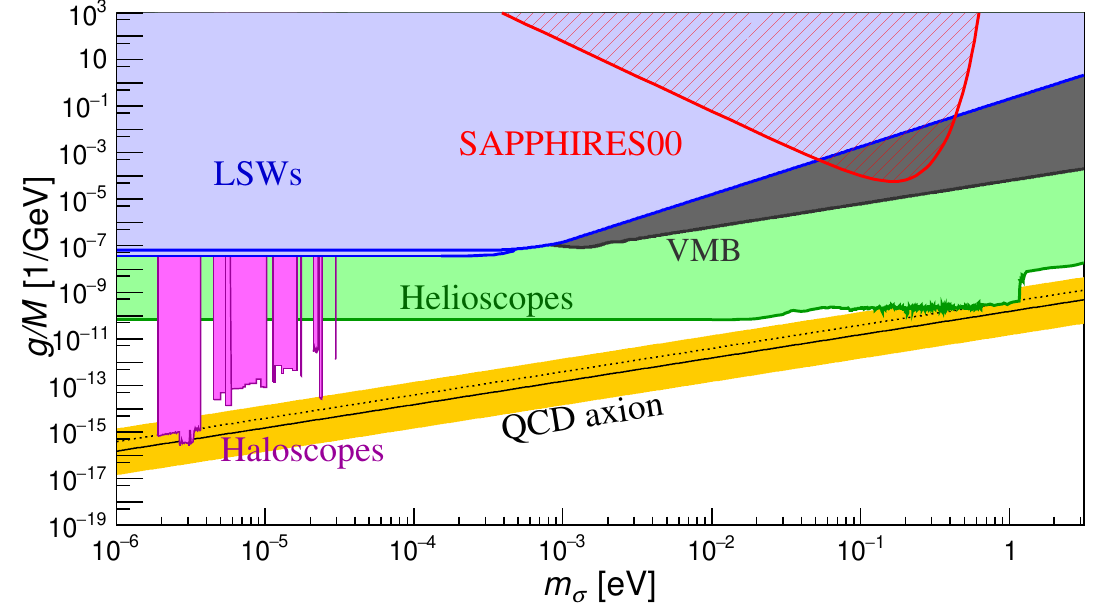
Figure 14 . Upper limits on coupling-mass relation for pseudoscalar fields ( σ ) exchanges. The red shaded area labeled “SAPPHIRES00” is the region excluded by this work (stimulated resonant scattering). The yellow band shows the coupling-mass relation based on the QCD axion predicted by the KSVZ model [19, 20] with | E/N − 1 . 95 | in the range 0.07–7 with the case of E/N = 0 (black dotted line). The case of the DFSZ model [17, 18] with E/N = 8 / 3 is also shown by the black solid line. The light-blue area is the region excluded by LSW experiments (OSQAR [34] and ALPS [35]) with respect to pseudoscalar fields. The gray area is the result from the “Vacuum Magnetic Birefringence (VMB)” experiment (PVLAS [36]). The green area shows upper limits from the “Helioscope” experiment (CAST [43–48]). The magenta areas are excluded regions from